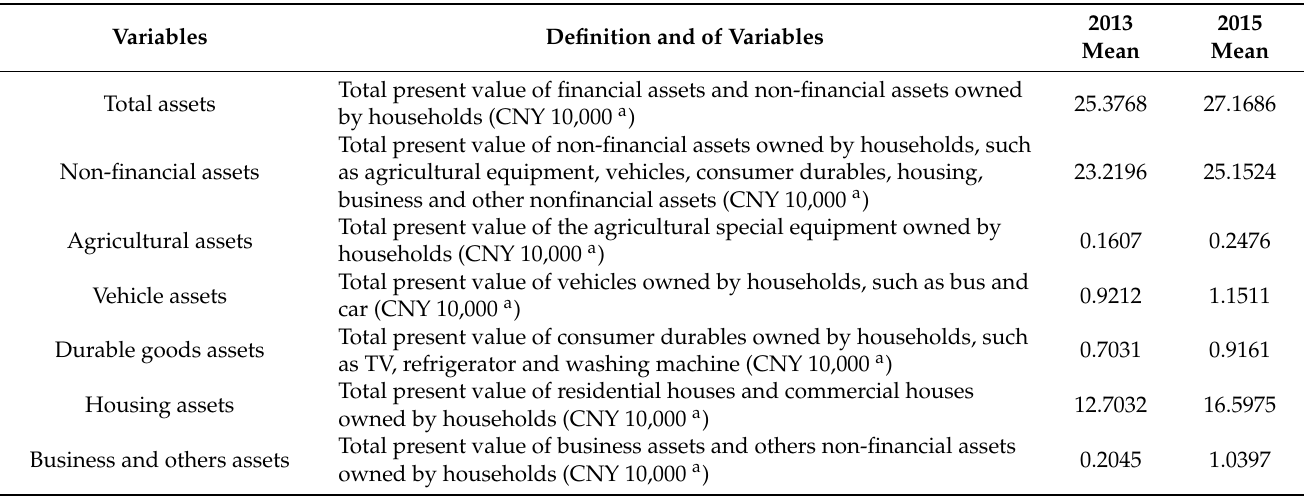
Table 1. Definition and description of